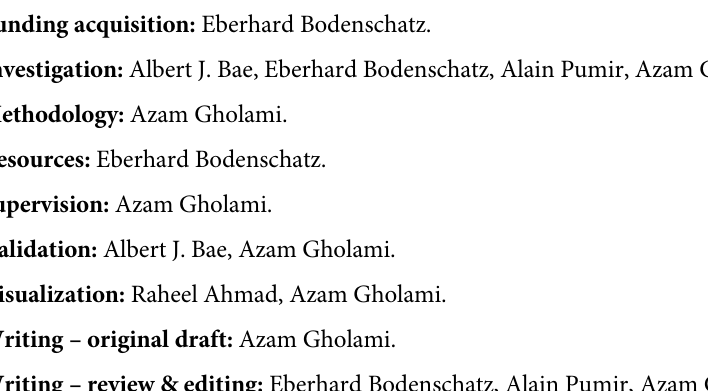
S6 Video. Experiment without calcium. Experimental beat pattern reported in Ref. [14] used for the analysis in Fig 8. Here [Ca 2+ ] = 0 mM and [ATP] = 80 μ M. (MOV) S7 Video. Experiment with calcium. Experimental beat pattern reported in Ref. [14] with [Ca 2+ ] = 0.1 mM and [ATP] = 80 μ